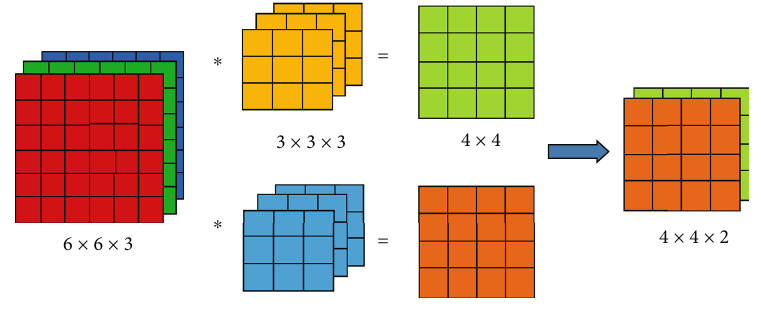
Figure 1: Multichannel